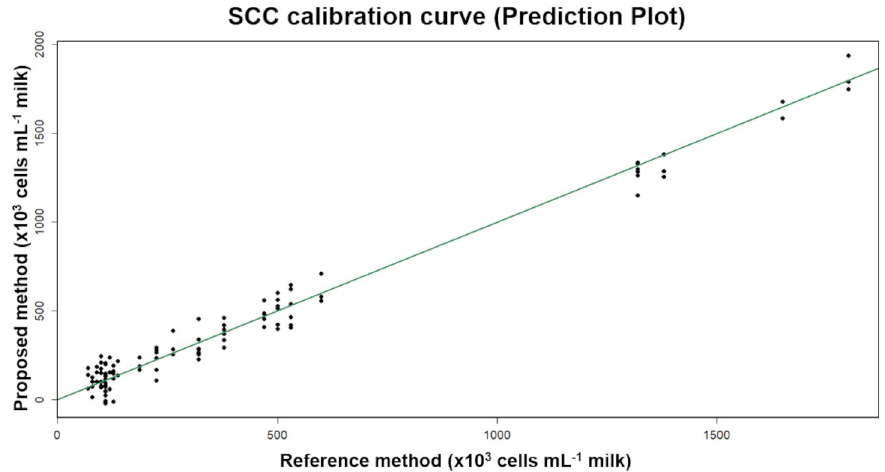
Fig 6. Multiple linear regression for CCS. Image processing analysis of predicted (RGB) vs. measured CCS. Adjusted R 2 = 0.97.